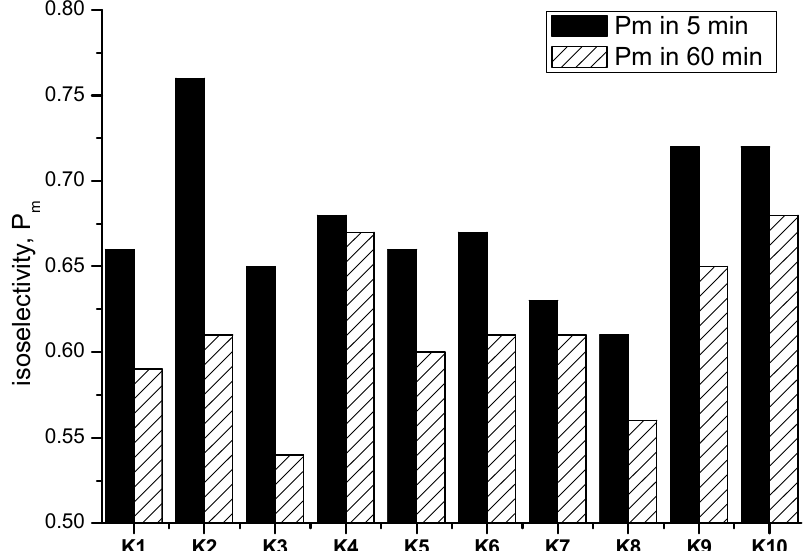
Figure 9. Comparing the isoselectivity of ROP by K1–K10 in 5 or 60 min.